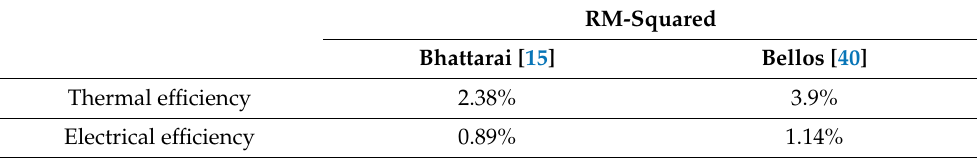
Table 2. Evaluation of RM-Squared.